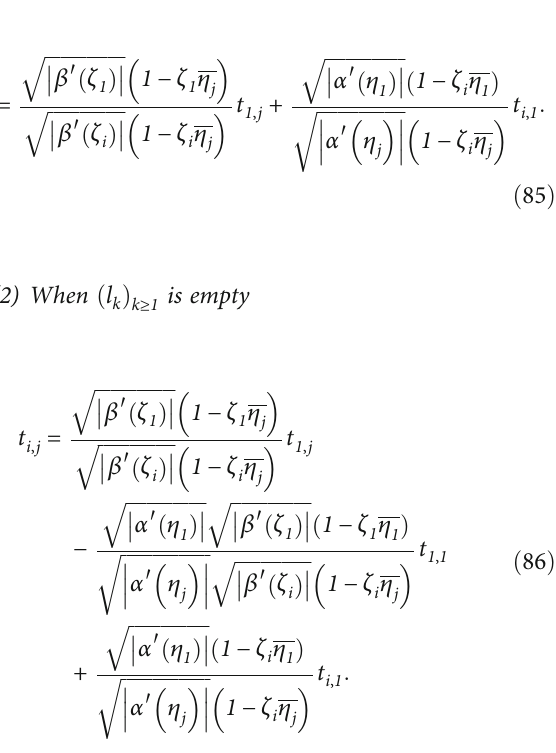
ffiffiffiffiffiffiffiffiffiffiffiffiffiffiffiffi (cid:12) β ′ ζ ð Þ (cid:12) 1